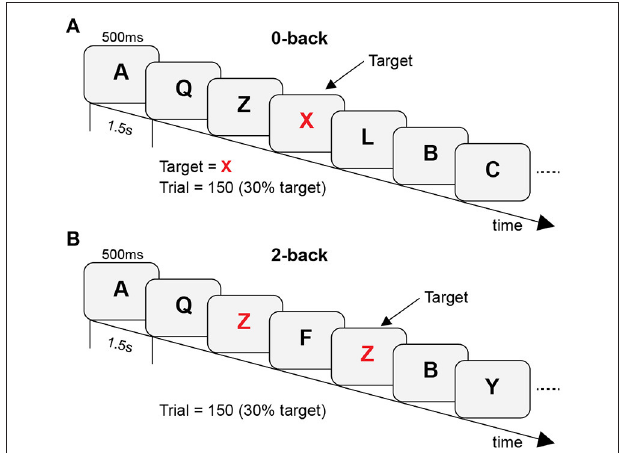
FIGURE 1 | A schematic diagram of the experimental protocol with (A) 0-back as control tasks and (B) 2-back as WM tasks.